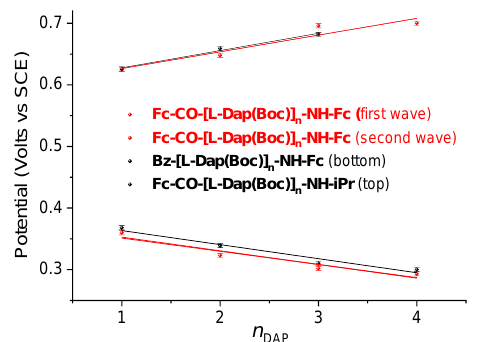
Figure 7. Variation in oxidation potentials of the 1 – 4 series. For comparison, the values for Bz – [ L - Dap(Boc)] n – NH – Fc, ( n = 1 – 4) and Fc – CO – [ L -Dap(Boc)] n – NH – iPr ( n = 1 – 3) are reported [23]. Each potential is presented as the mean value of manifold measures (error bars ± 3 mV).